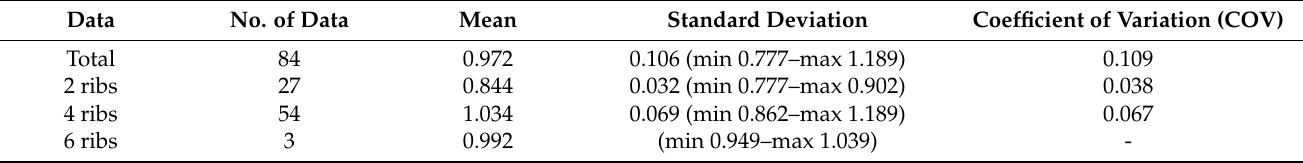
Table 6. Statistical characteristics of estimations by Equation